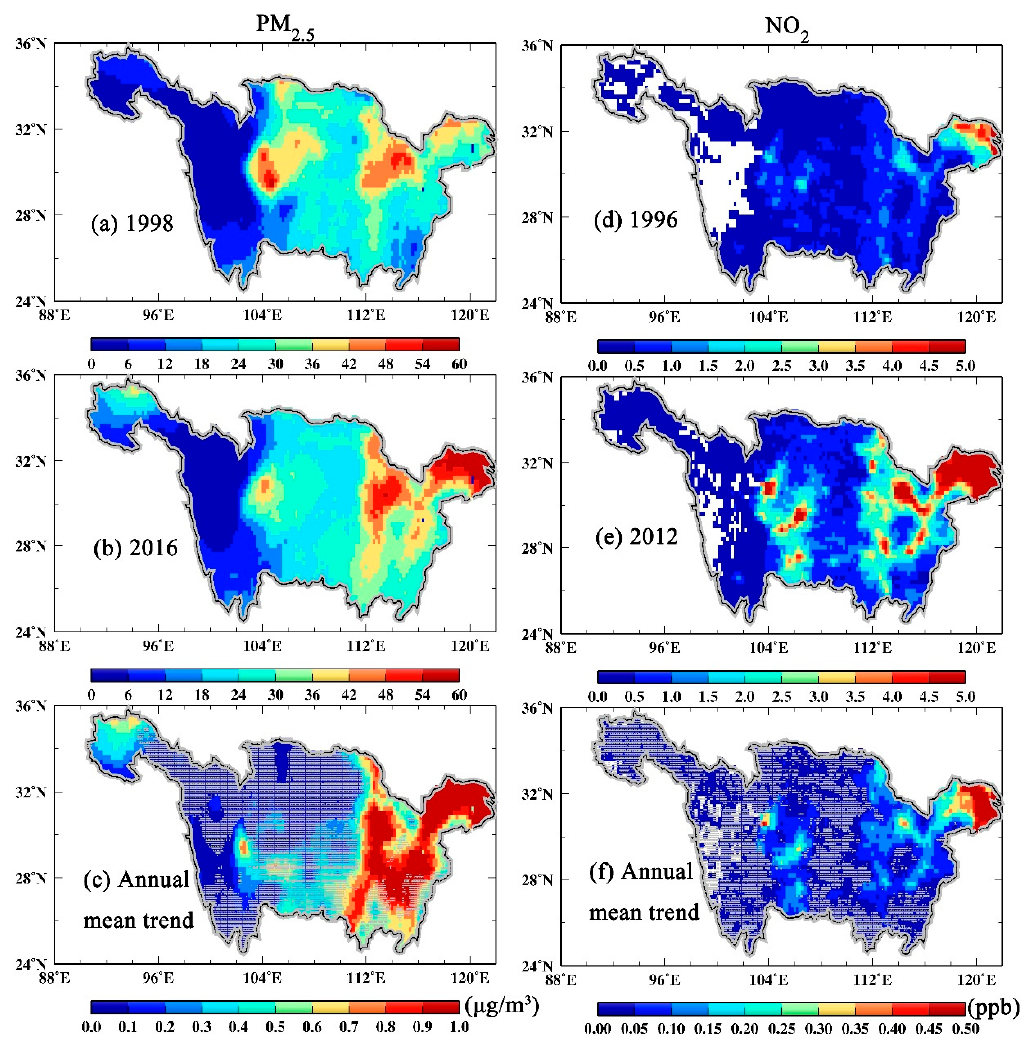
Figure 4. Spatial distributions of annual mean near-surface PM 2.5 ( c ) and NO 2 ( f ) concentrations over the YRB. Pixels covered by gray lines refer to those trends not passing the 95% significant level. Besides, annual mean PM 2.5 (left) and NO 2 (right) are also shown in 1998 ( a ), 2016 ( b ), 1996 ( d ) and 2012 ( e ), respectively.